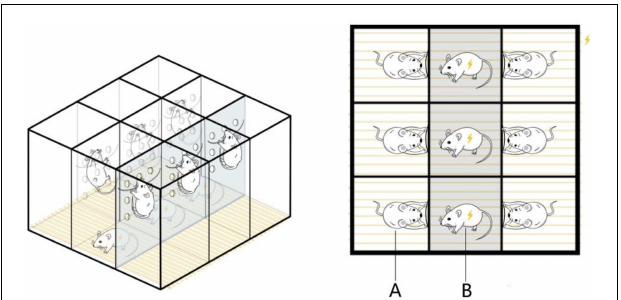
FIGURE 1 | Equipment for the psychological fear stress rat model. (A) The pregnant rats can climb onto the wires fixed on the partition to avoid electric shock, but they can observe the pain response behavior of the male and experience fear as a result. (B) The male rats cannot avoid electrical stimulation, so they emit painful screams, jump, and lose excretory control during the electrical